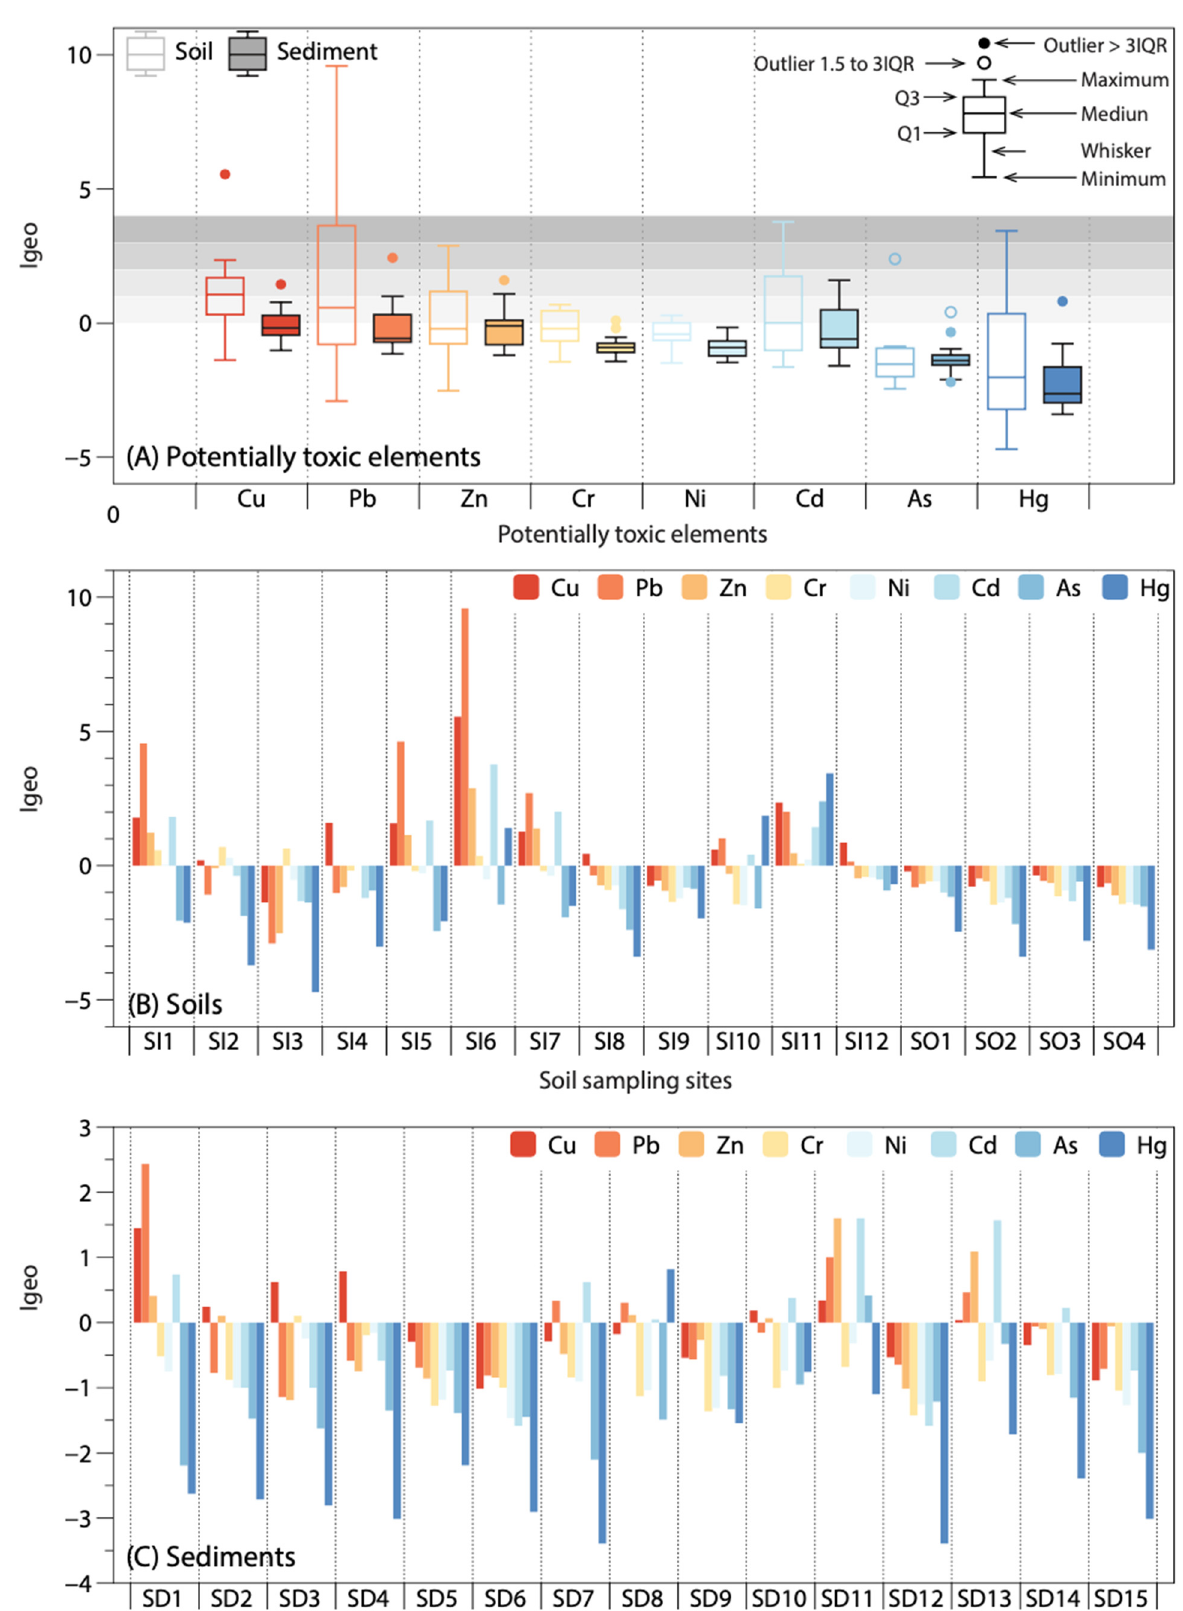
Figure 3. I geo of PTEs in soils and sediments.